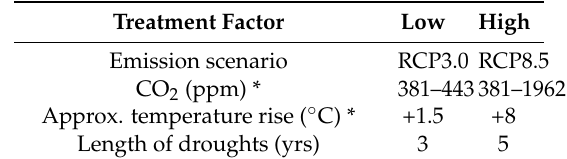
Figure 1. Soil types (and Available Water Capacity) used in the study area in Oconto county (Wisconsin, USA), to allow comparison with Gustafson et al. [4]. Non-forested areas are unshaded and were not included in the simulations. Used with permission. Table 4. Levels of the landscape-scale experimental treatment factors, resulting in 4 combinations Table 3. Selected life history attributes of species used in the landscape experiment. of